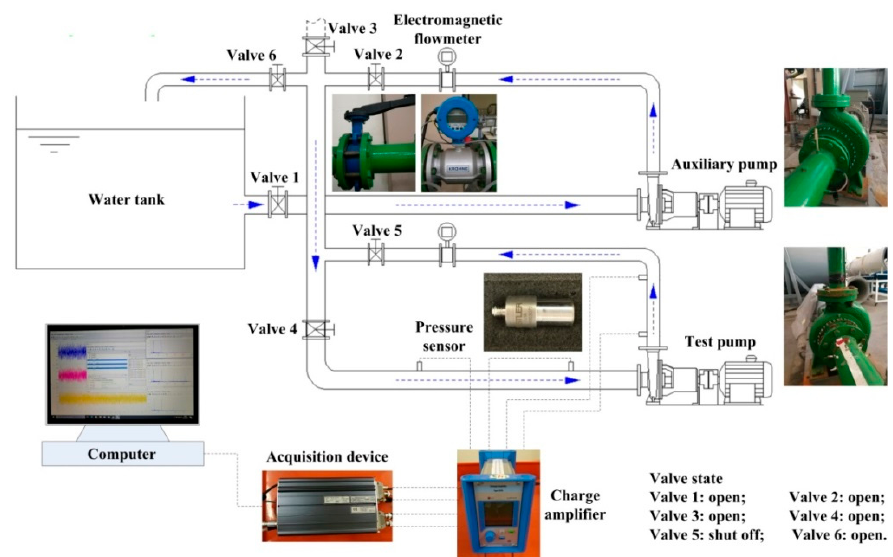
Figure 1. Schematic view of the experimental